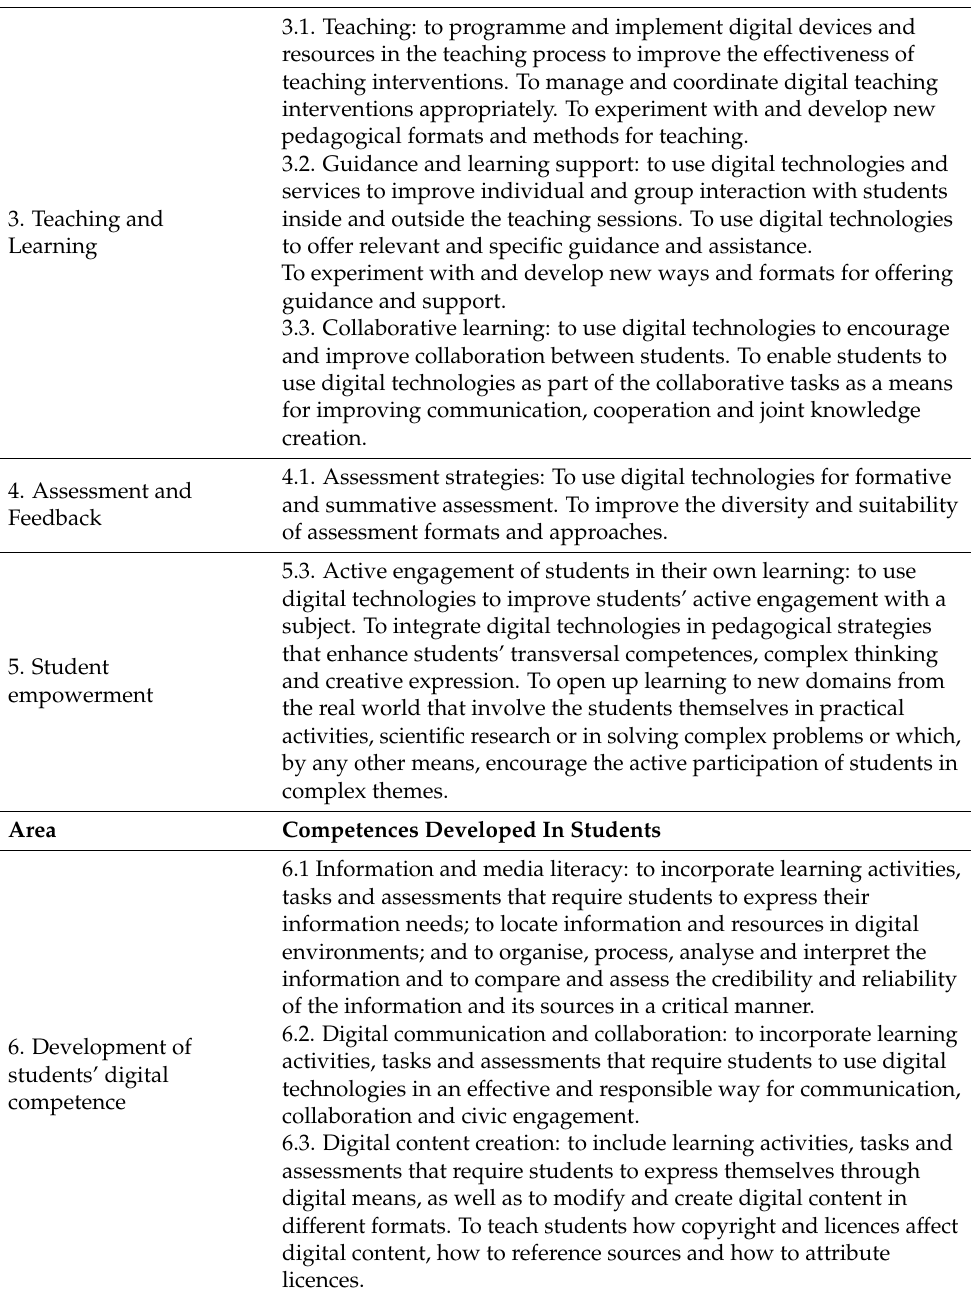
Table 1. DigCompEdu digital competences developed with the MICROFEST project (Source: European Commision